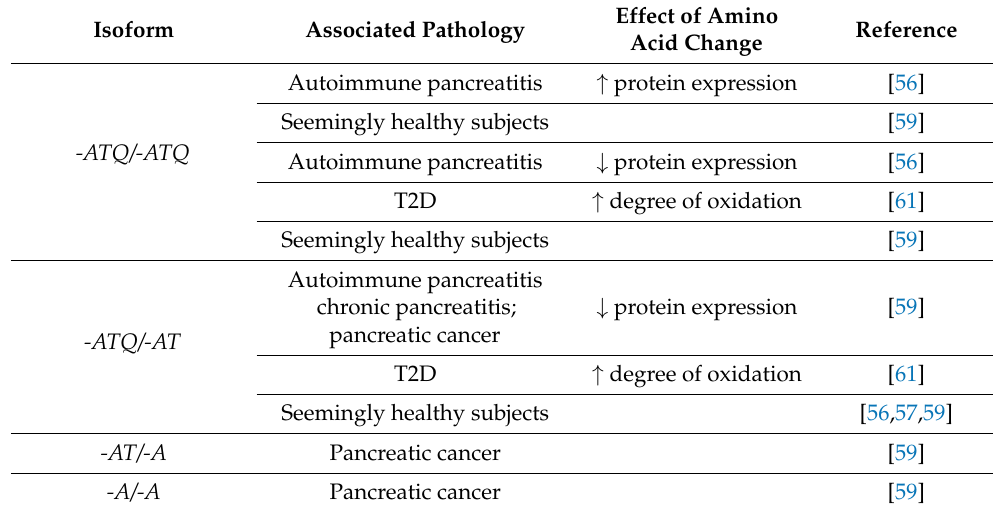
Table 2. ApoA-II isoforms and the pathologies associated with these